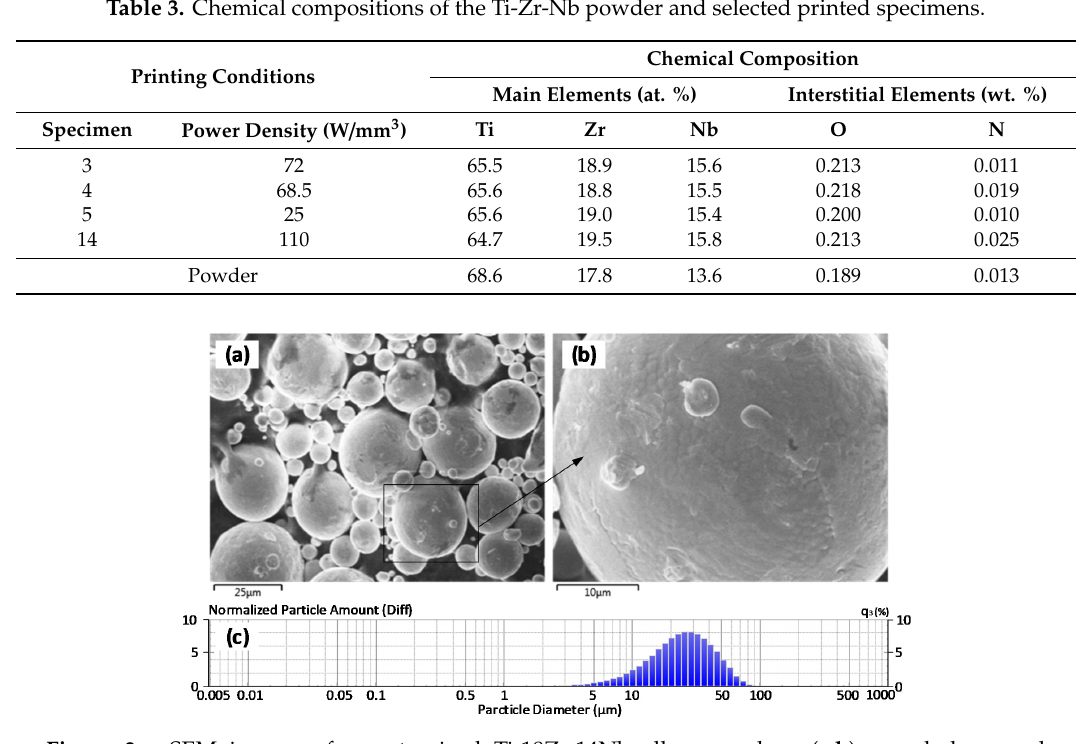
Table 2. Physical properties of the Ti-Zr-Nb alloy in bulk and powdered forms used for process modeling.